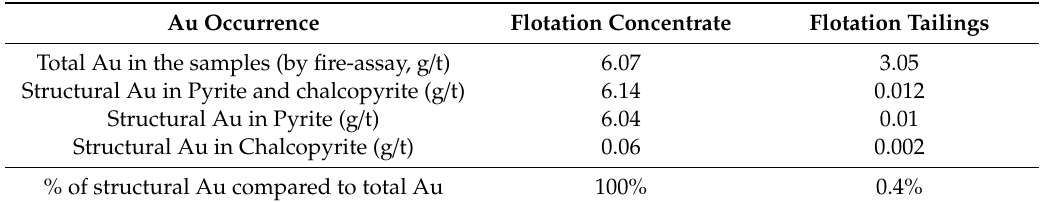
Table 4. Compilation of the Electron Probe Micro-Analysis (EPMA) analyses of pyrite and chalcopyrite for the structural Au quantification.